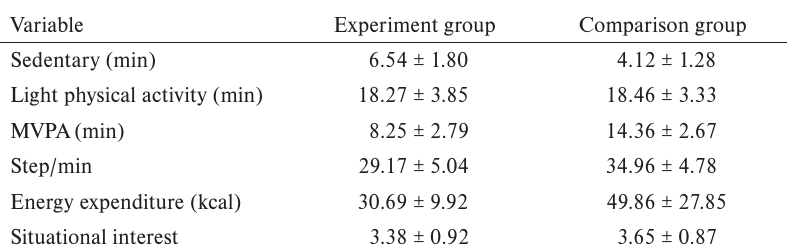
Descriptive statistics of the variables across five lessons (M ± SD)